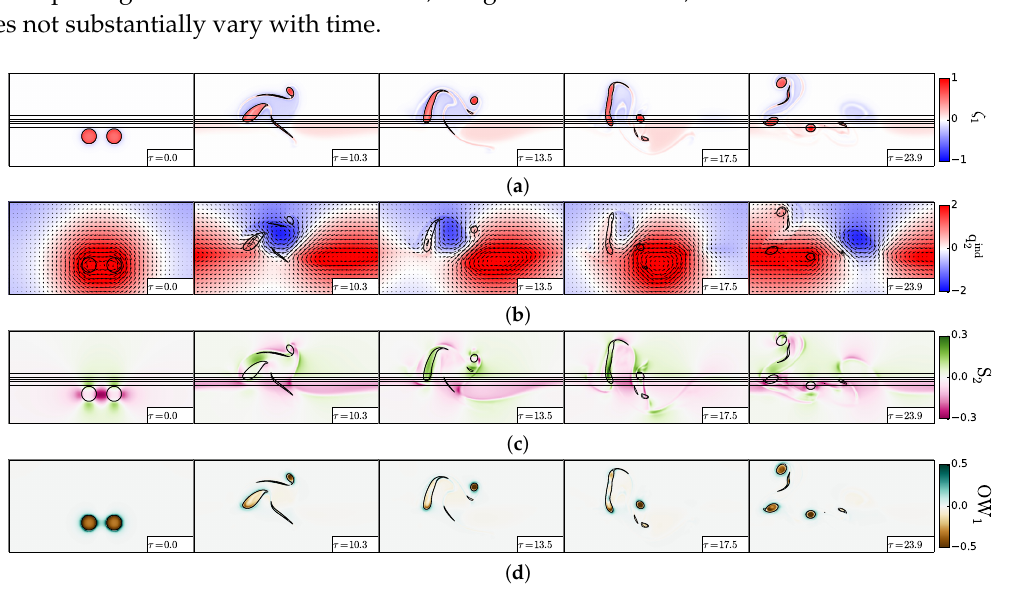
Figure 8. Merger and splitting of two cyclones, case d / R = 3.4, γ R = 3, d c / R = 2. ( a ) Upper layer relative vorticity (Equation (2)); ( b ) lower layer “equivalent barotropic” potential vorticity (Equation (11)); ( c ) lower layer velocity shear (Equation (5)); ( d ) upper layer Okubo–Weiss quantity (Equation (7)). The black contours indicate the topographic slope (Equation (12); straight lines) and the upper layer vorticity contours showing the two vortex evolution.